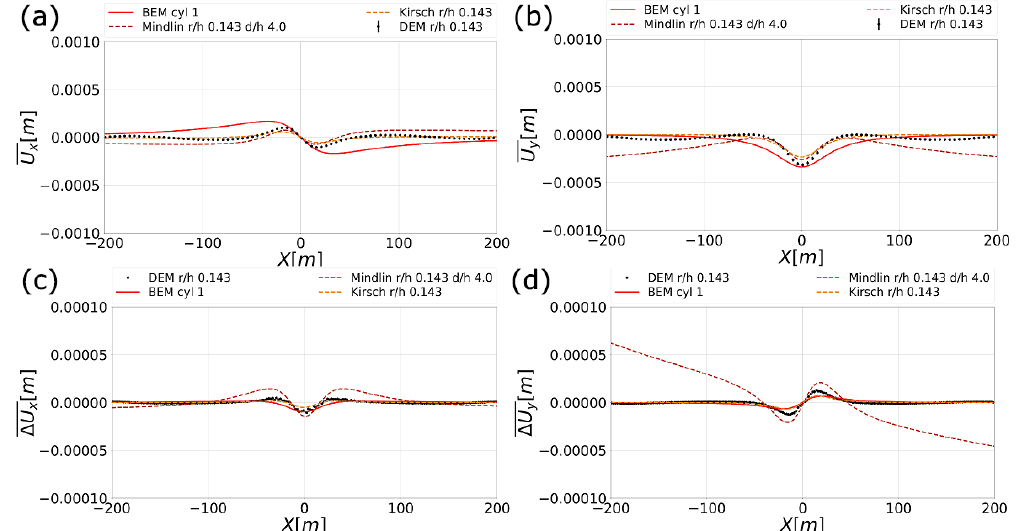
Figure 5. Results of benchmarking of the DEM cavity model against continuum-based cavity models: analytical solutions and modelled displacement curves for model dimensions of 400 × 400m with particle radius 0.32m. The reference is a cavity with r/h = 0 . 143, at 35m depth and with a 5m radius. (a) Horizontal displacement, (b) vertical displacement, (c) horizontal displacement difference and (d) vertical displacement